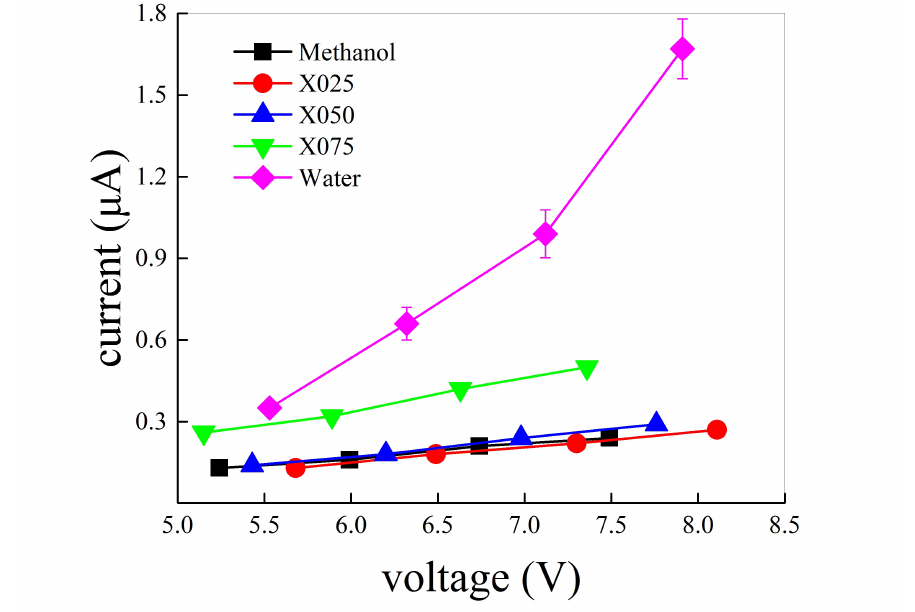
Figure 4. Protonic current-voltage diagram of neat methanol (black squares), methanol-water mixtures with molar ratios equal to 75:25 (red circles), 50:50 (upward blue triangles), 25:75 (downward green triangles), and neat water (magenta diamonds). Error bars are proportional to the number of conducting protons and can be discerned from the respective points only in the neat water